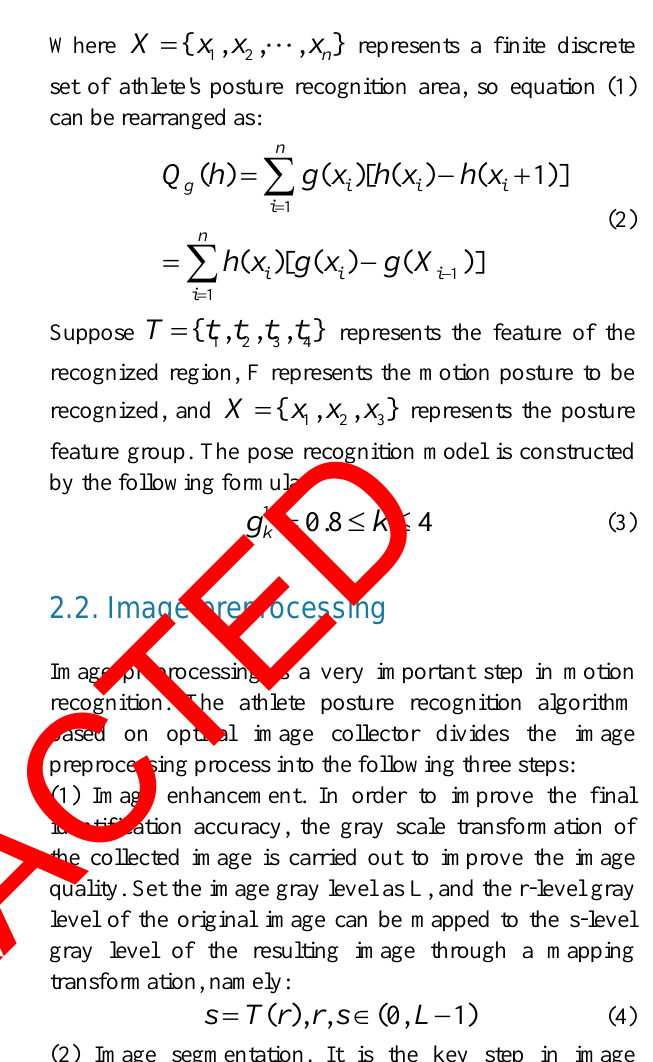
Figure 1. Proposed